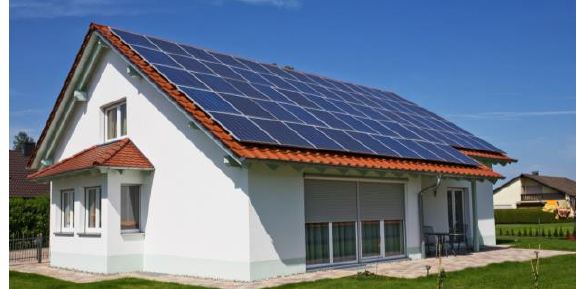
Figure 1. Solar panel on building roof, example of an active solar - PV system (Berkeley Lab, 2010).